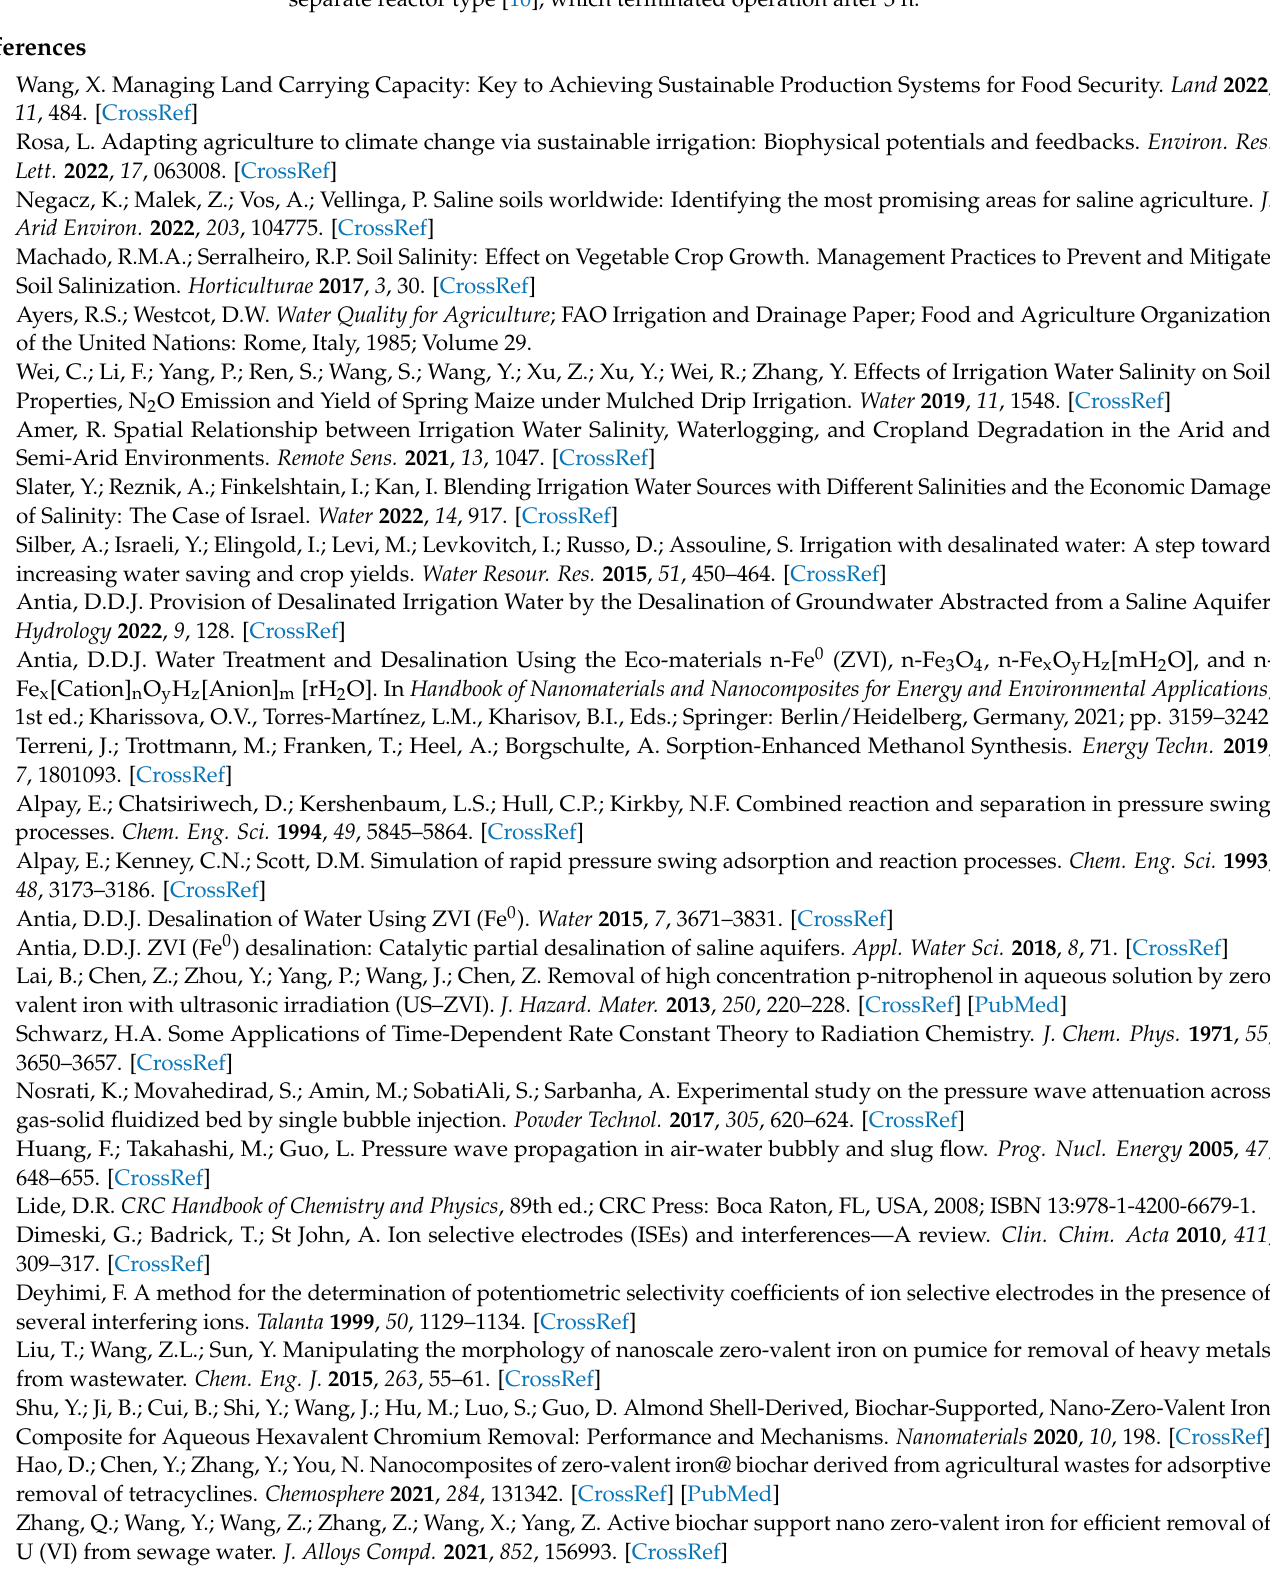
line = minimum ion removal; green line is 25% probability of a lower removal; red line is 50% probability of a lower ion removal; brown line is a 75% probability of a lower ion removal; blue line is a 98% probability of a lower ion removal. Vertical orange line is this study. Vertical purple line is a separate reactor type [10], which terminated operation after 3